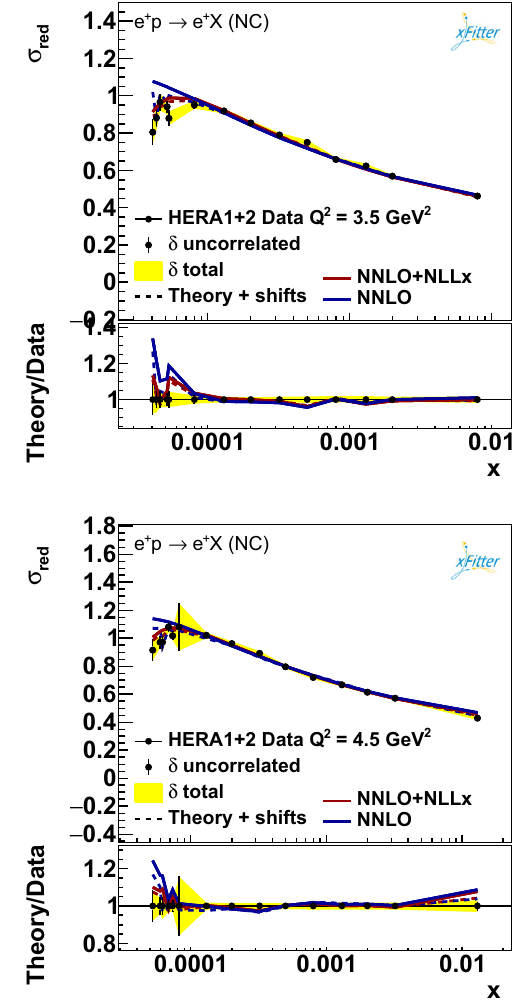
Fig. 7 The HERA NC E p = 920 GeV data compared to the fits with and without ln ( 1 / x ) resummation for the Q 2 = 3 . 5 and 4 . 5GeV 2 bins